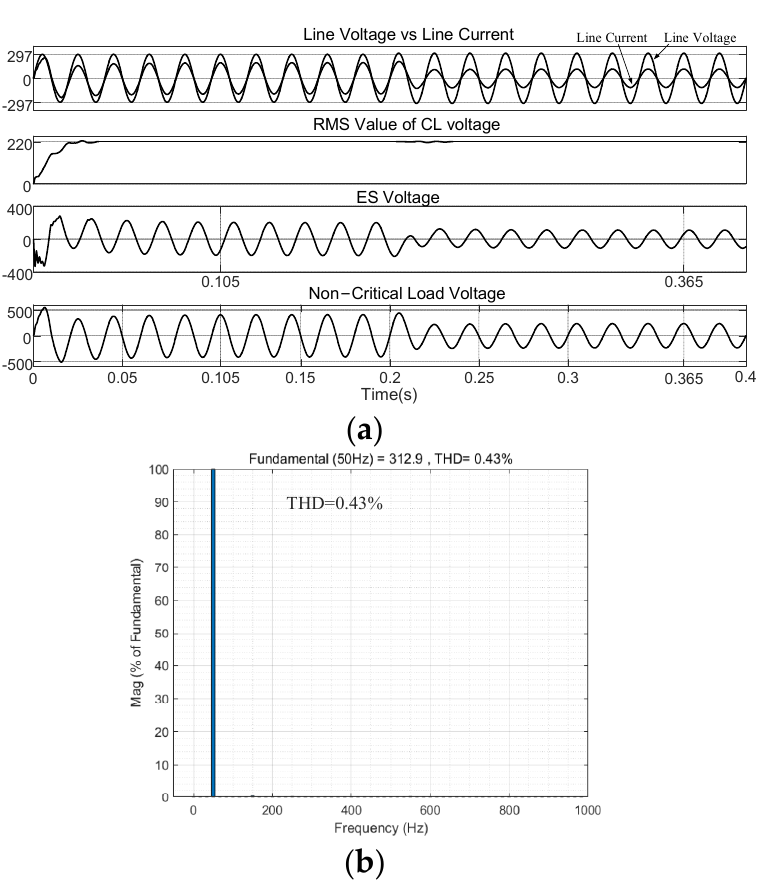
Figure 7. Simulation waveforms at PFC mode. ( a ) Four channels of waveforms. ( b ) THD analysis of critical load voltage. critical load